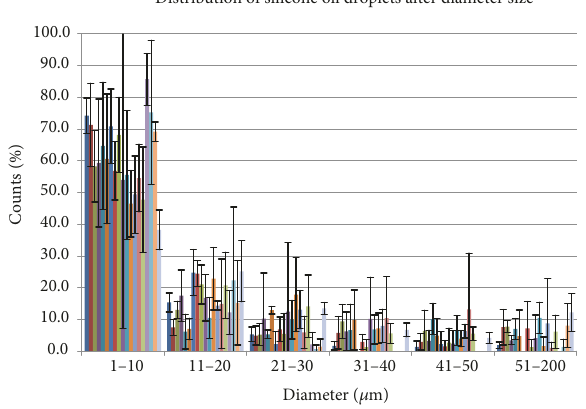
Figure 3: Distribution of silicone oil droplets after diameter size, in % with standard